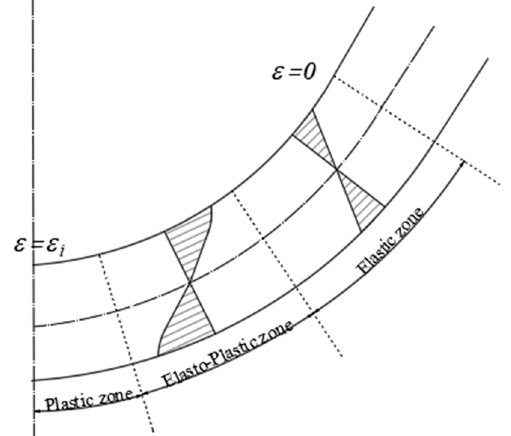
Figure 7. Deformation zone in bending.